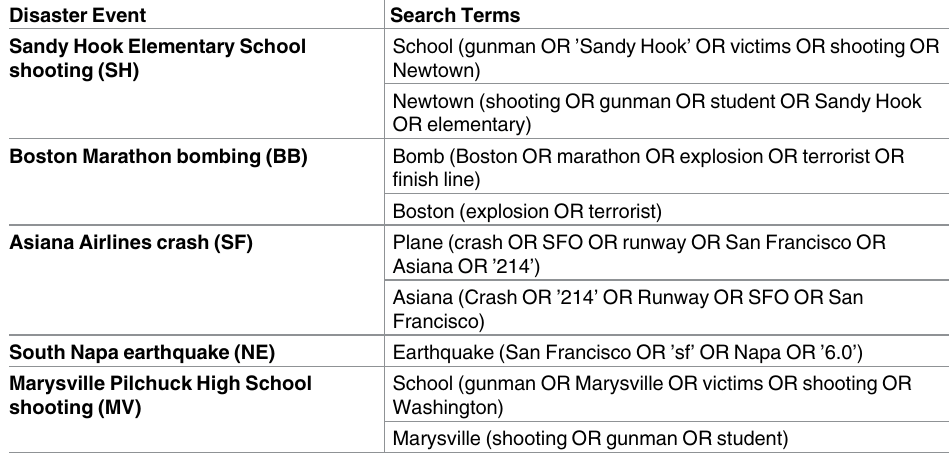
Table 1. Search terms for 5 multiple casualty